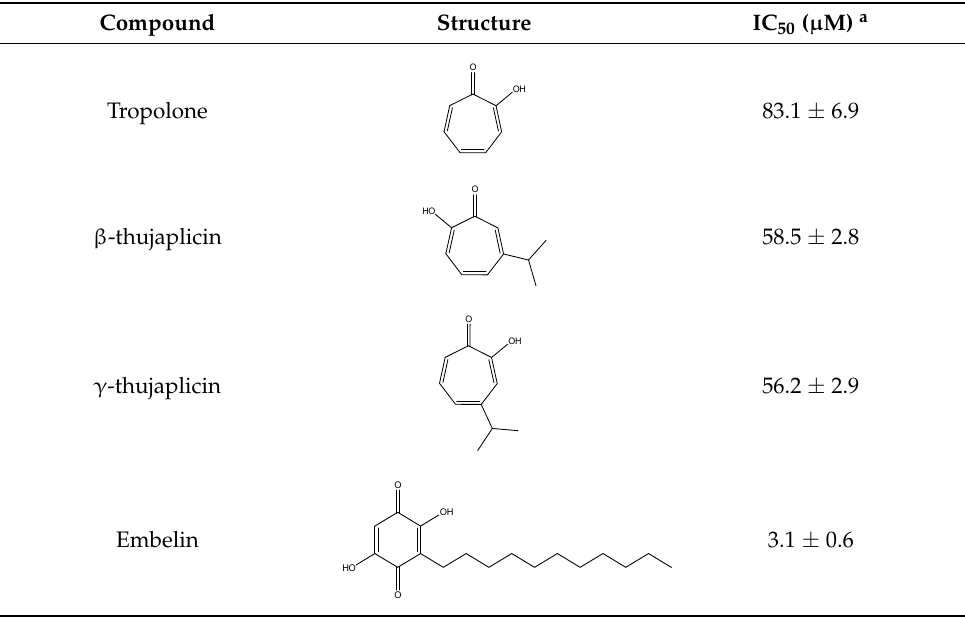
Table 1. Effects of tropolone derivatives on the binding of the Smac N-terminal peptide to the XIAP-BIR3 domain.